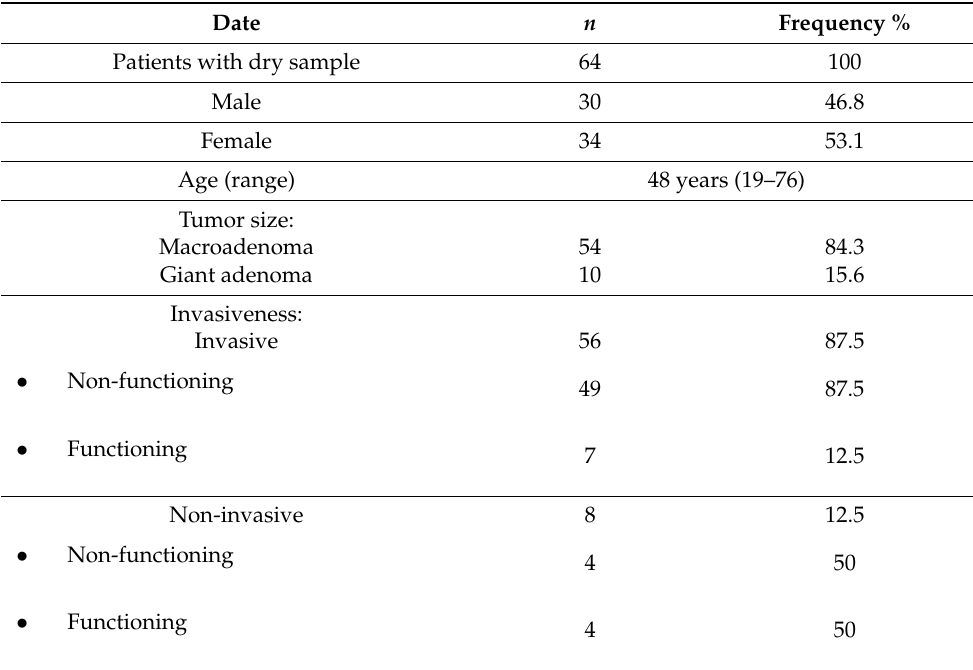
Table 3. Pituitary adenoma